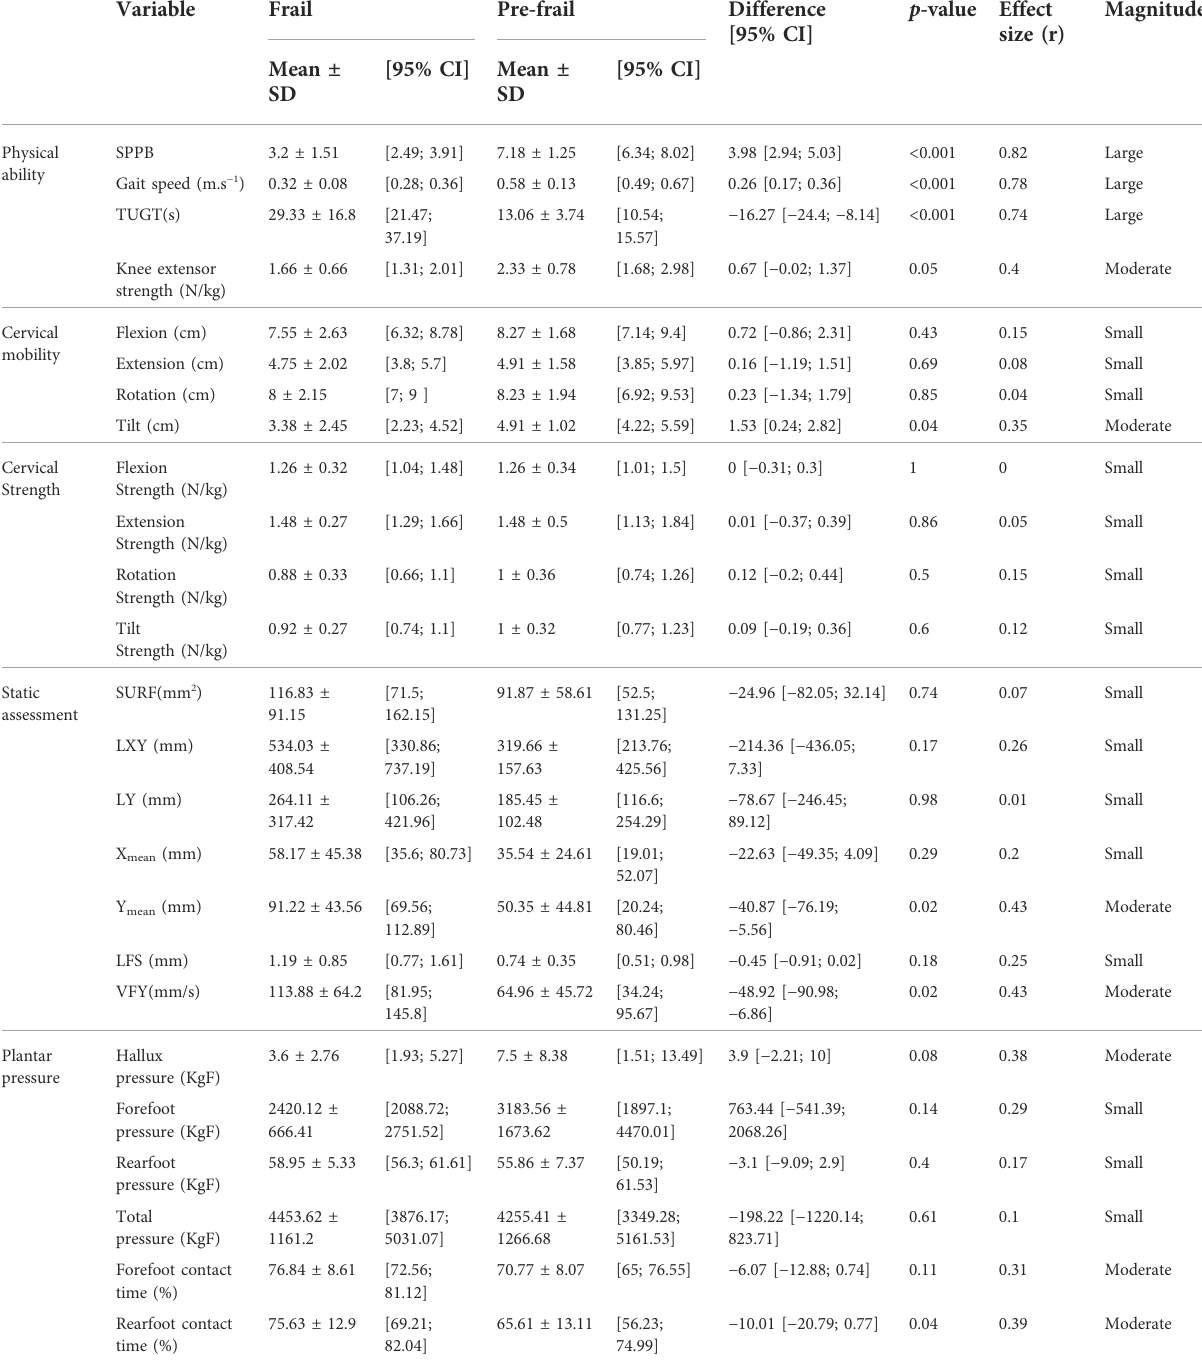
TABLE1Physicalability,cervicalmobility,strength,staticassessment,plantarpressureinPre-FrailandFrailsubjects.Alldataarepresentedasmean± standard deviation with a 95% con fi dence interval (CI).